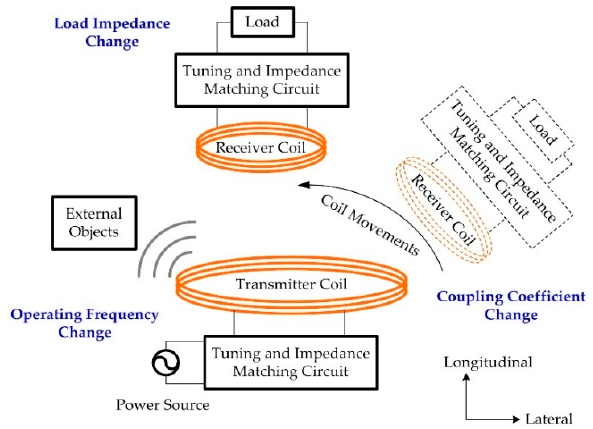
Figure 1. Structure of a WPT system using CMR.